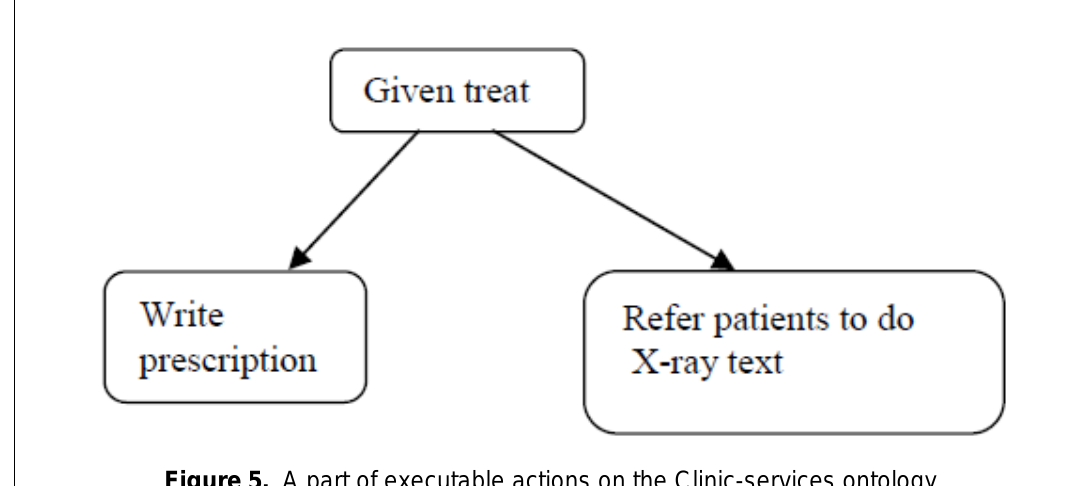
Figure 5. A part of executable actions on the Clinic-services ontology